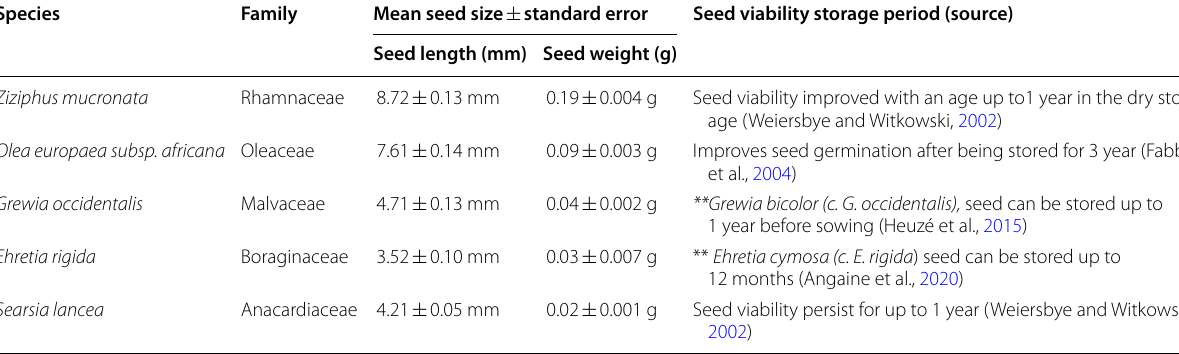
Table 2 Seeds attributes for different tree/shrubs that were included in the germination